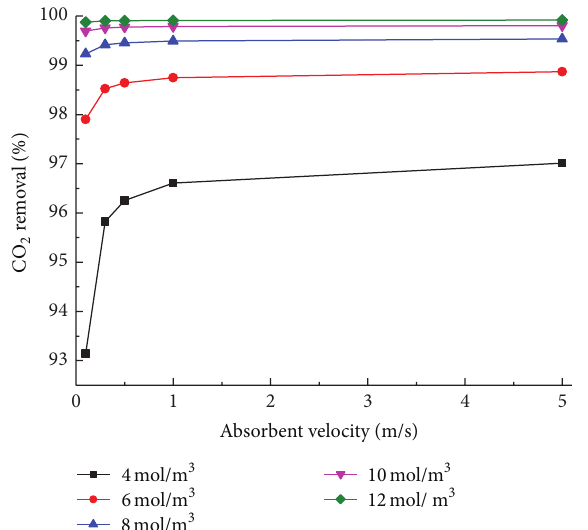
Figure 9: Removal percentage under different liquid velocity. 𝑟 1 = = 0.2 mm, 𝑟 = 0.3 mm, 𝐿 = 900 mm, 𝐶 0.15 mm, 𝑟 2 3 = 0.2 m s −1 0.5 molm −3 , and V CO 2